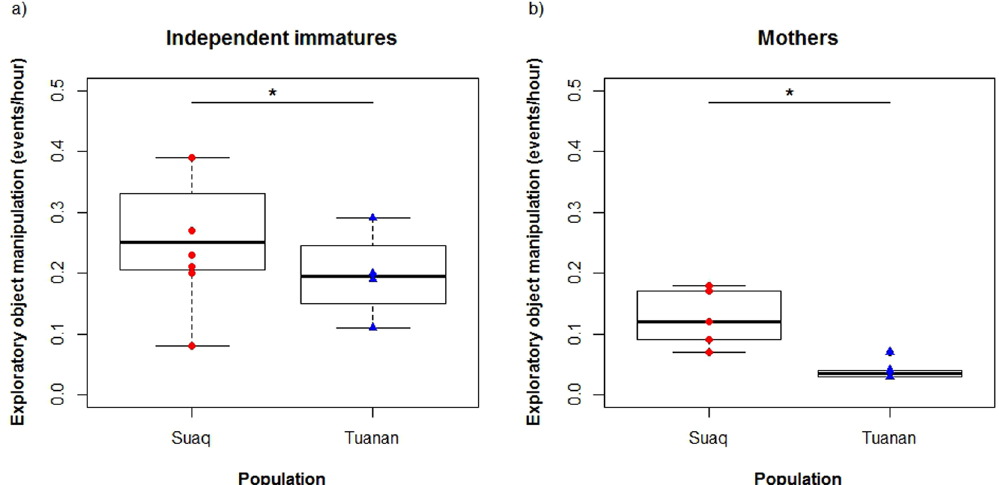
Figure 5. Rates of exploratory object manipulation (events per observation hour) for independent immatures ( a ) and adults ( b ) at Suaq versus Tuanan.